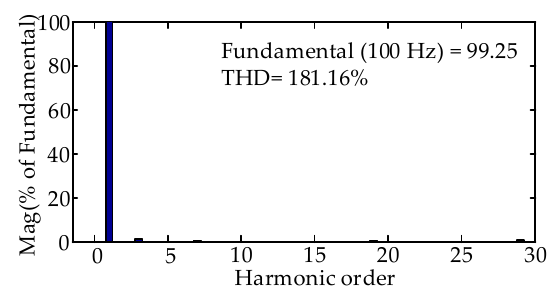
Figure 7. Spectrum analysis of u ab